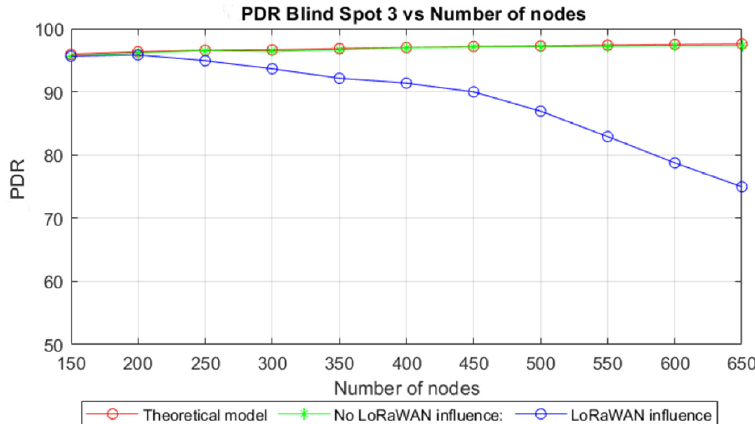
Figure 18. Influence of the LoRaWAN transmissions on the average PDR.